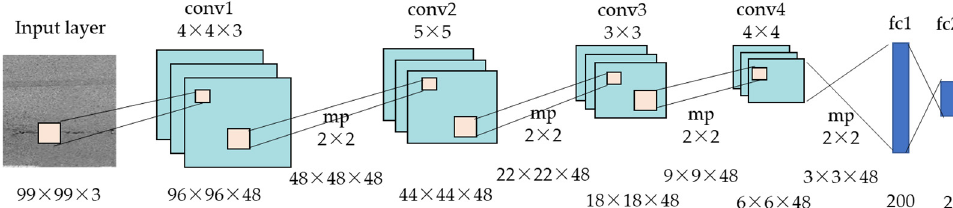
Figure 2. Illustration of the ConvNet architecture presented in [12].